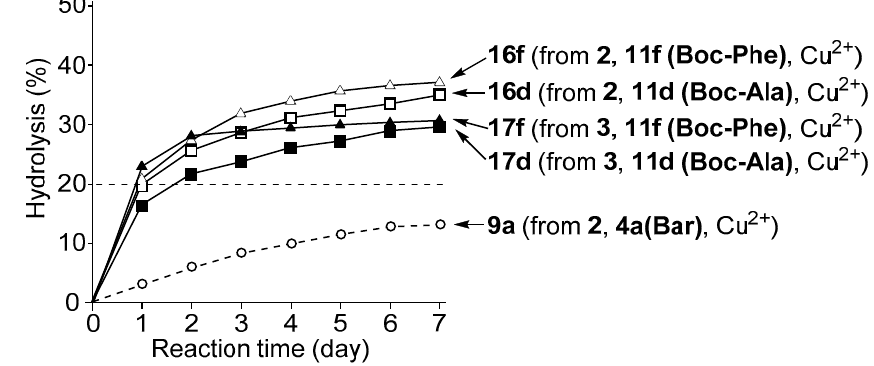
Figure 7. Hydrolysis of MNP (100 µ M in the total solution) by 9a (open circles), 16d (open squares), 16f (open triangles), 17d (closed squares), and 17f (closed triangles) ([ 9 , 16 , 17 ] = 20 µ M in the total solution) in CHCl 3 / 50 mM HEPES bu ff er (pH 7.4) with I = 0.1 (NaNO 3 ) (2 / 8) at 37 ◦ C. The concentrations of the product (4-nitrophenol) were determined in the total two-phase solvent